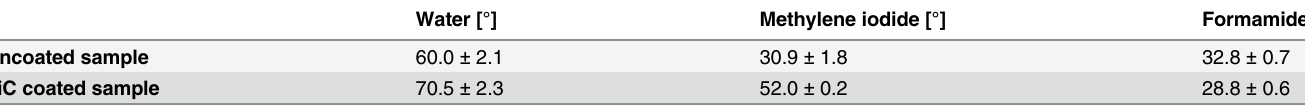
Table 1. Contact angle on uncoated and TiC coated titanium